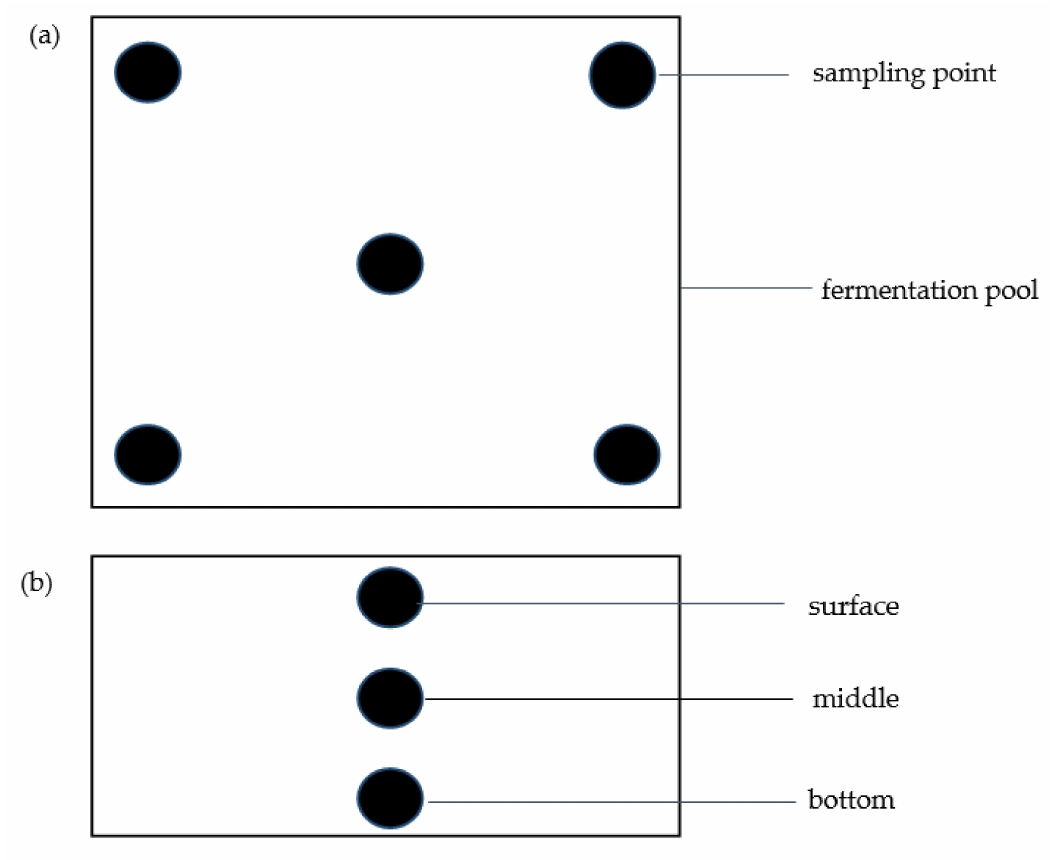
Figure 1. Sampling demonstration diagram of fish sauce fermentation broth: top view ( a ) and front view ( b